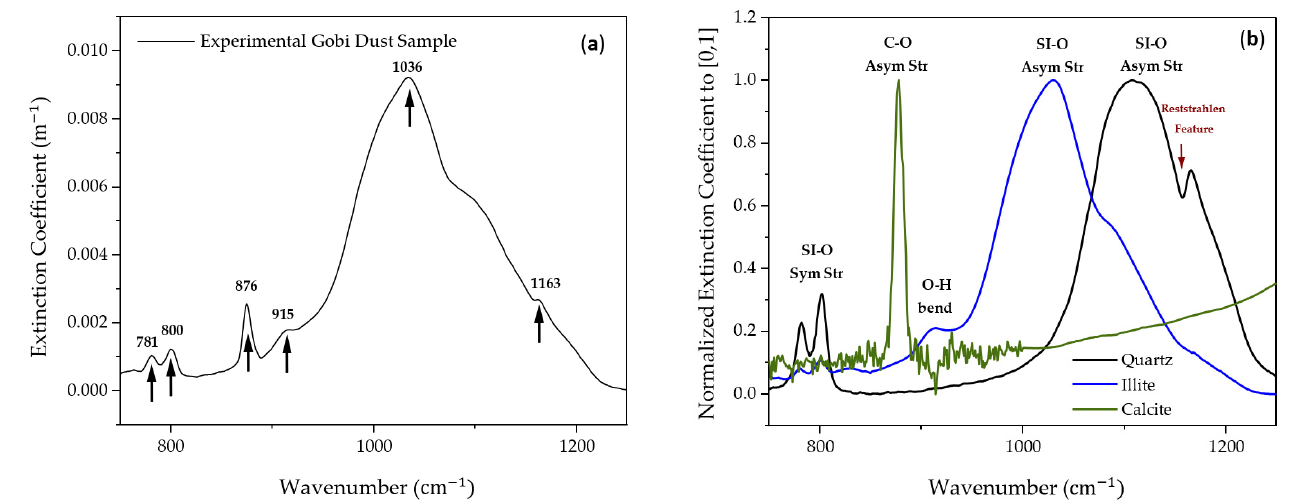
Figure 10. Laboratory extinction coefficient by FTIR of ( a ) Gobi dust samples, with arrows indicating extinction peaks, and ( b ) normalized extinction coefficient to [0, 1] for the pure minerals quartz, illite, and calcite with their molecular assignments (Adapted with permission from Ref. [52]). Sym Str: symmetrical stretching; Asym Str: asymmetrical stretching; Bend: